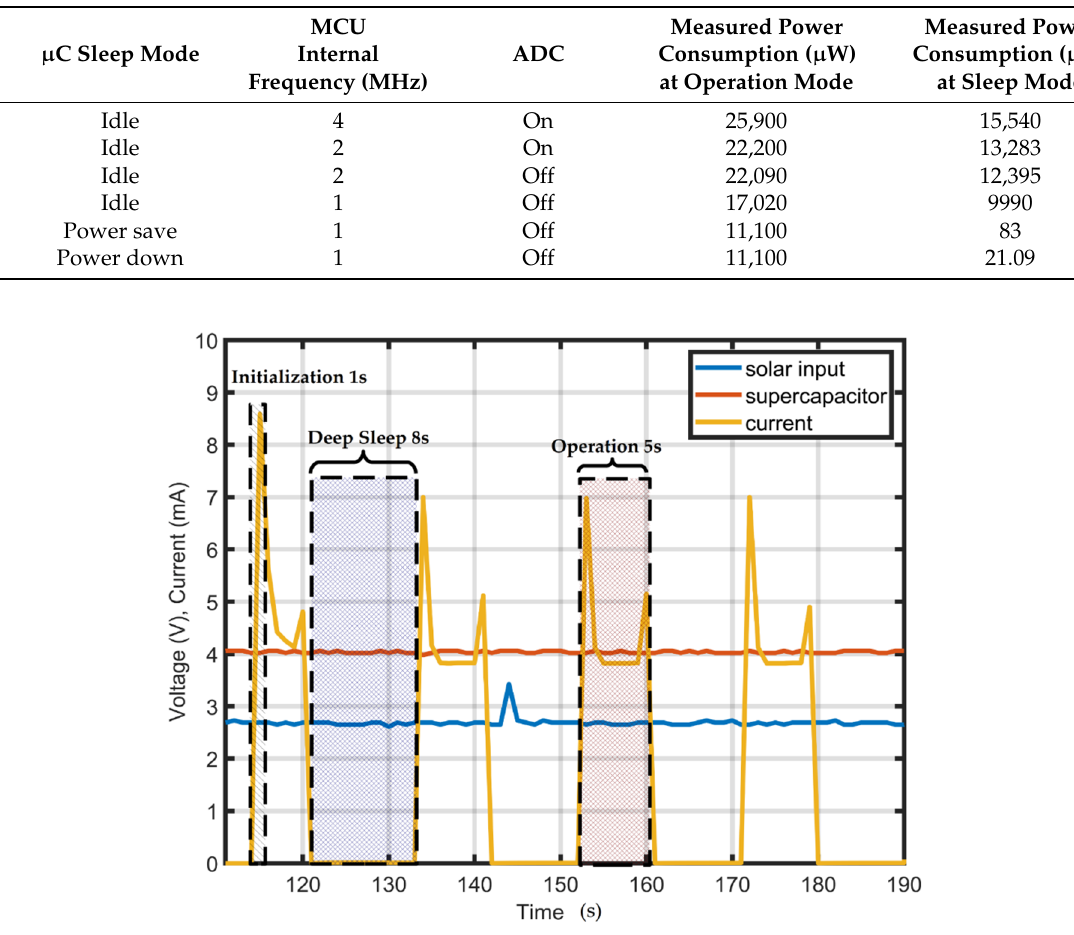
Figure 21. WSTx measured current consumption during the initialization, operation, and deep sleep mode.